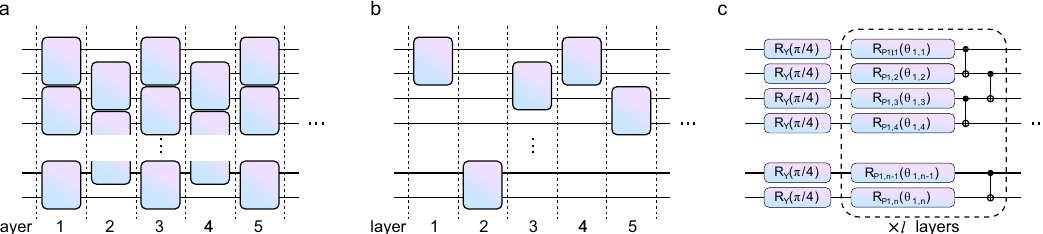
Fig. 2 Illustration of ansätzes used in this work. All ansätzes assumes 1D nearest-neighbor connectivity. a Parallel random unitary ansätze. Each layer is a wall of two-qudit random unitaries on neighboring qudits, and the next layer is offset by 1 qudit. This creates a brickwork motif, and the gate count scales as O ( ln ). b Local random unitary ansätze. Each layer is a single two-qudit random unitary between a pair of randomly chosen neighboring qudits. The gate count scales as O ( l ). c Hardware-ef fi cient ansätze. A wall of R Y ( π /4) rotations is followed by alternating layers of random Pauli rotations and controlled-NOT gates, all independently parameterized. Circuits with controlled-phase gates are also studied.